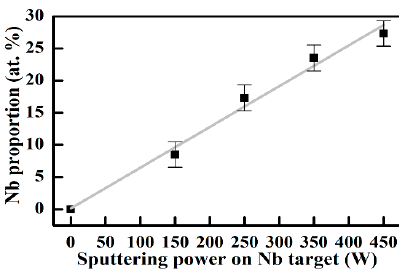
Figure 2. The proportions of niobium (Nb) versus different sputtering powers on Nb target.